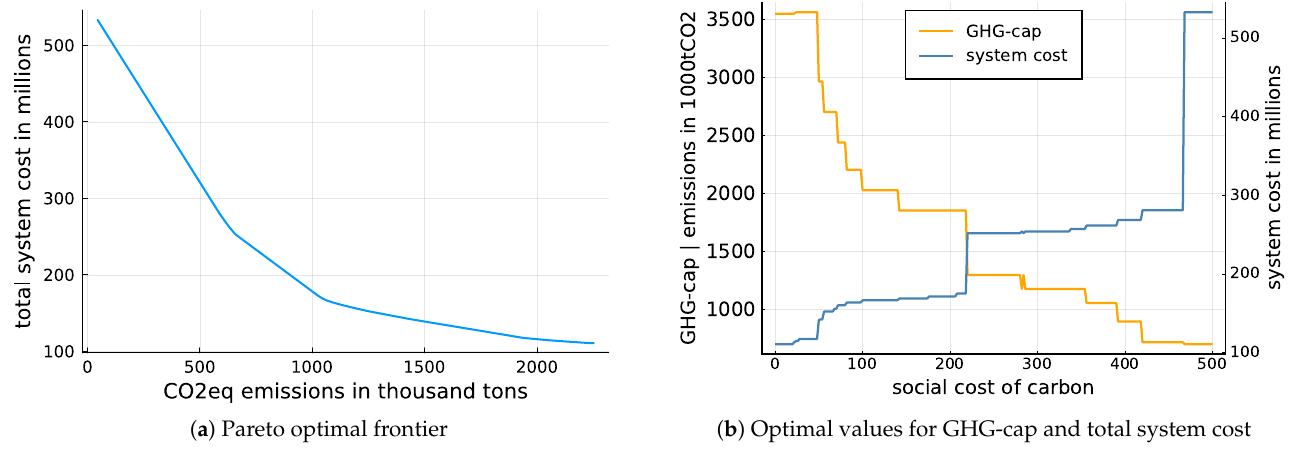
Figure 4. ( a ) shows the Pareto optimal frontier for trading off the total cost of generation against total GHG emissions. Every point on the shown frontier is an optimal solution with respect to the policymaker’s a priori preference relation regarding both objectives; ( b ) shows the resulting policy decision dependent on the chosen level of SCC , as well as the associated expected total system cost in millino $US.